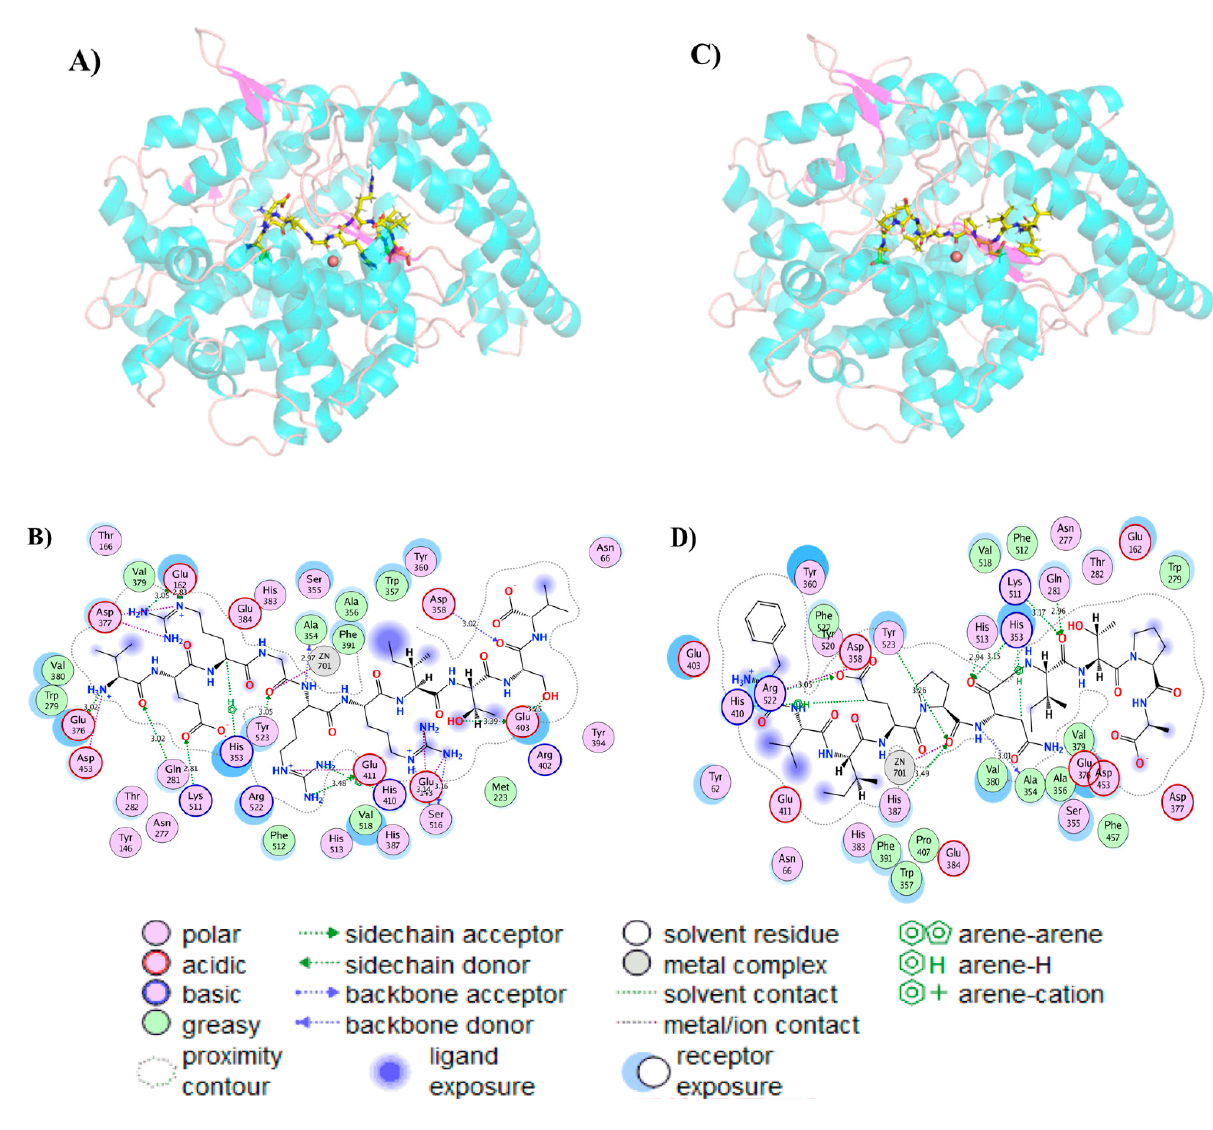
Figure 4. The best binding conformation of the pure peptides with ACE (PDB: 1O8A). 3D diagram of VERGRRITSV ( A ), 2D diagram of VERGRRITSV ( B ), 3D diagram of FVIEPDITPA ( C ), 2D diagram of FVIEPDITPA ( D ).